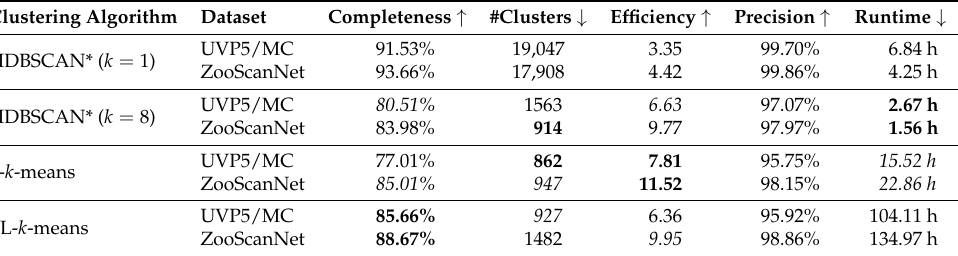
Table 2. Comparison of clustering algorithms regarding completeness, number of resulting clusters, efficiency, sorting precision and clustering runtime. The best result for each respective metric is bold, the second best is italic. Clustering Algorithm